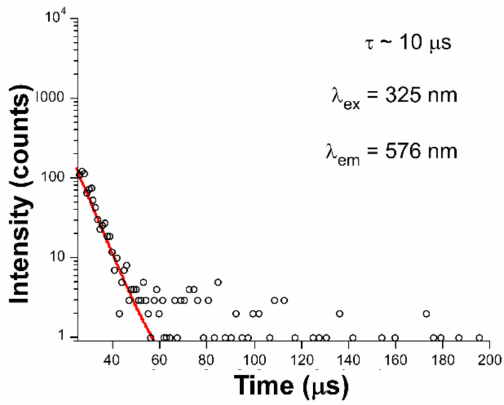
Figure 4. The ( a ) excitation ( λ em = 576 nm) and ( b ) emission ( λ ex = 325 nm) spectra of compound 2, acquired at room temperature.